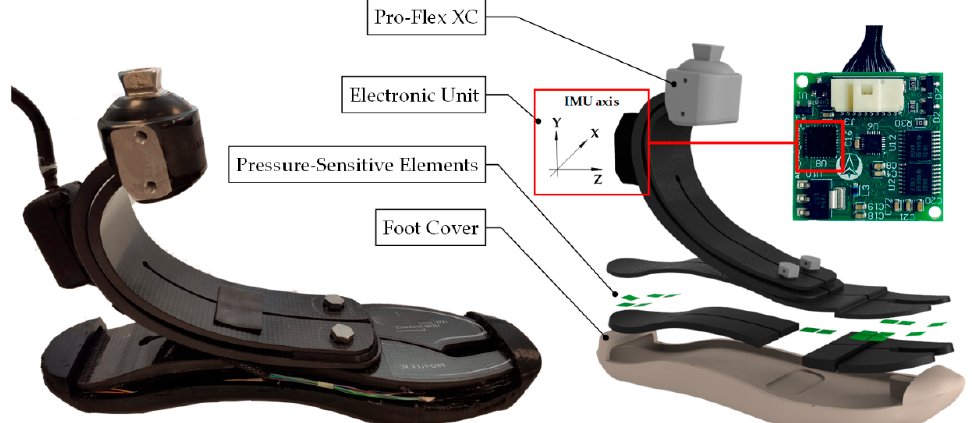
Figure 1. Overview of the system with an exploded view of the SPF: the electronic unit is enclosed inside a black plastic box, and it is endowed with an IMU (axis orientation is reported); the prosthetic foot, i.e., Pro-Flex XC, Ossur ® ; pressure-sensitive elements are made up of black silicone pads and PCBs; a 3D printed foot cover encloses the sensing elements and cables to prevent failures.